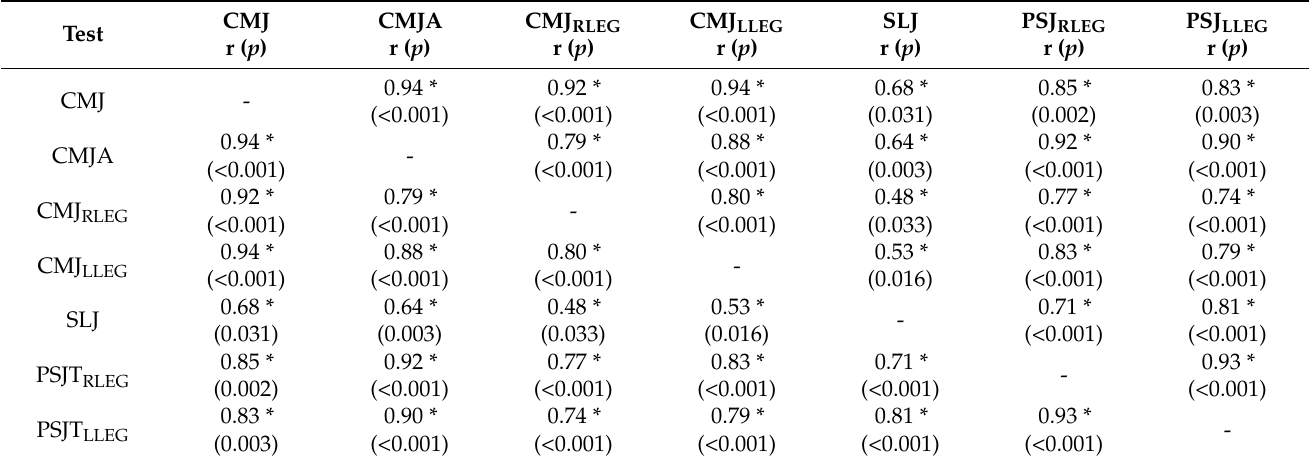
Table 7. Intercorrelation matrix of the PSJT and the other jump tests for EGB (females, n =